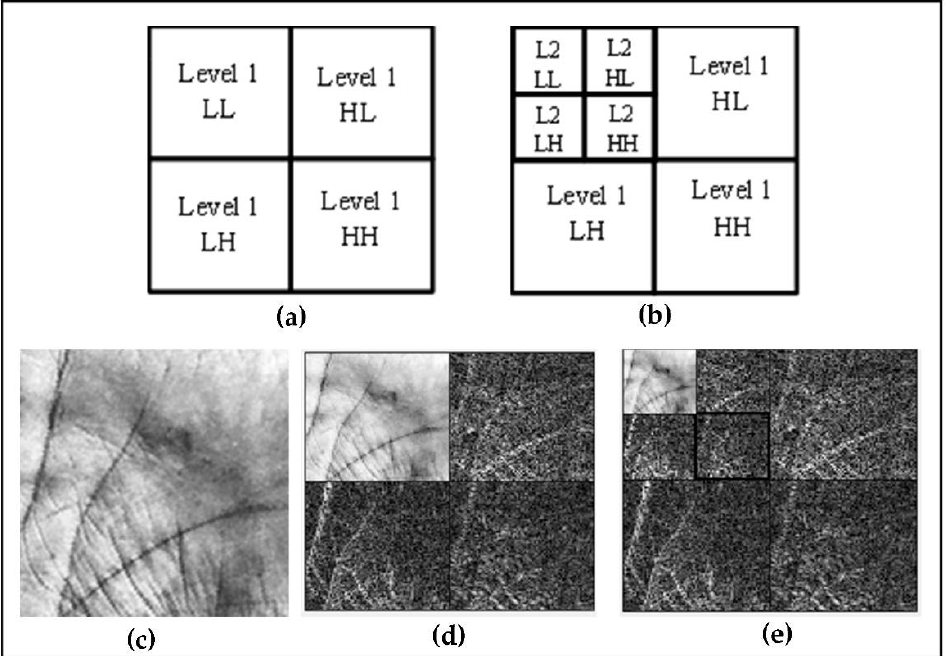
Figure 1. The 2D wavelet decomposition. ( a ) Concept of one-level components. ( b ) Concept of two-level components. ( c ) Original palmprint image from IITD database. ( d ) The 2D-DWT at first level. ( e ) The 2D-DWT at second level.